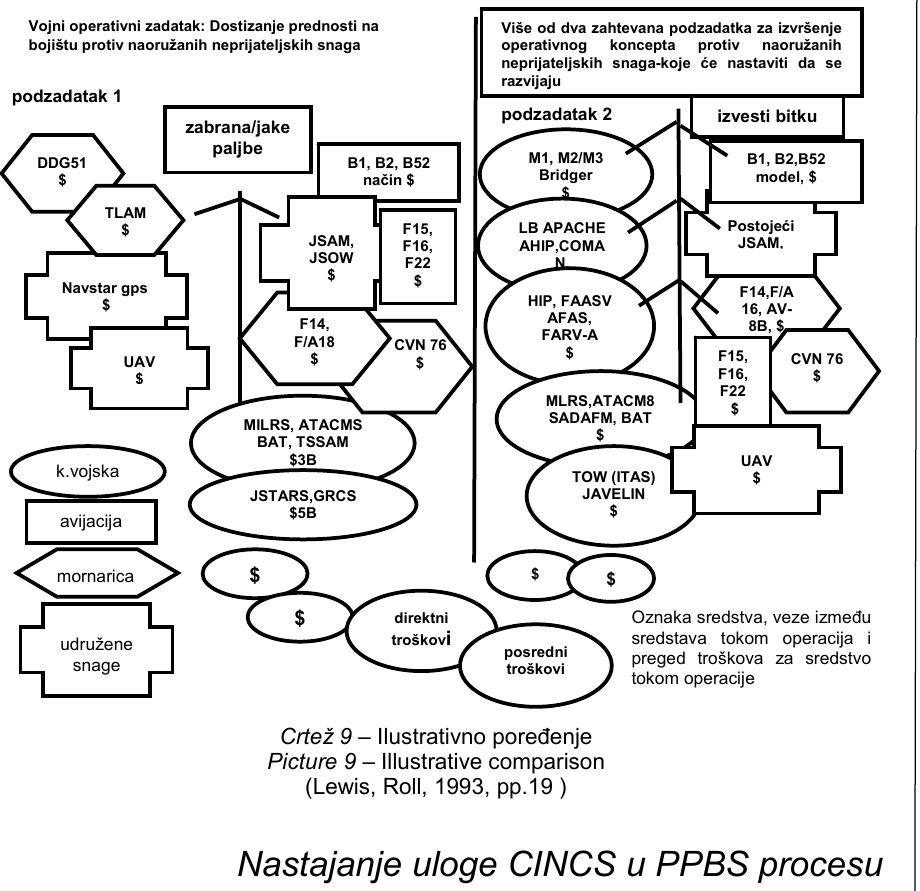
Picture 9 – Illustrative comparison (Lewis, Roll, 1993, pp.19